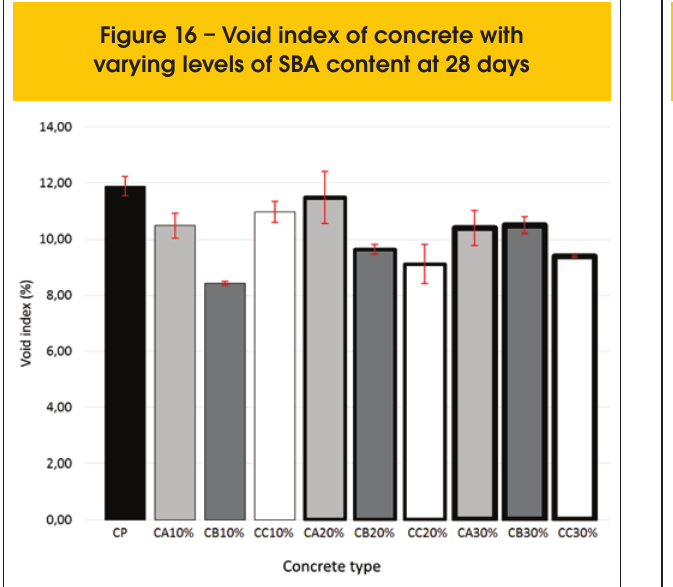
Figure 16 – Void index of concrete with varying levels of SBA content at 28 days